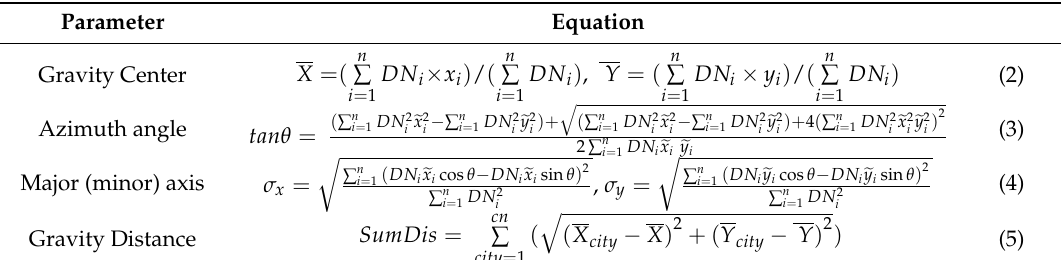
Table 1. Equations of the growth pattern change in megaregion scale and city scale (Gravity Center [48] and Standard Deviational Ellipse [49]). Pixel value DN i and its geographic coordinates of ( x i , y i ) are used to calculate the Gravity Center in megaregion scale ( X , Y ) or a city scale ( X city , Y city ), where n represents the related scale pixel number, θ is the azimuth of the weighted Standard Deviational Ellipse, indicating the angle measured clockwise from the North to the major axis of the ellipse. The major (minor) axis is calculated using the standard deviation in the θ direction (perpendicular to θ ), which corresponds to the dispersion degrees of geographical features in the major and minor direction, respectively (cid:101) x i = x i − X and (cid:101) y i = y i − Y , which refers to the distance of the i th pixel to the Gravity Center. The total sum of the Euclidean distances, ( SumDis ) between the Gravity Center of individual city ( X city , Y city ) and the Gravity Center of the megaregion ( X , Y ) represents urban Gravity Distance, where cn represents the related city